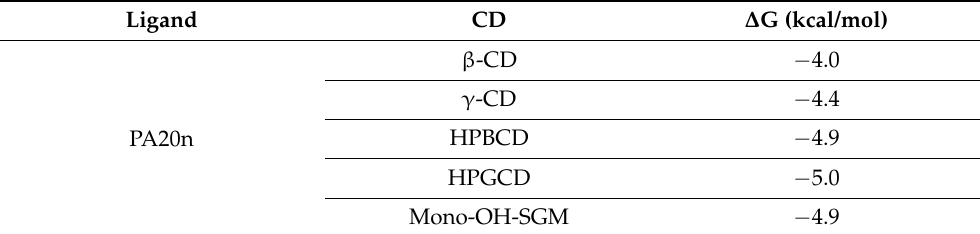
Table 2. Free binding energy values of PA20n (PAA) following docking into various cyclodextrins. Ligand CD